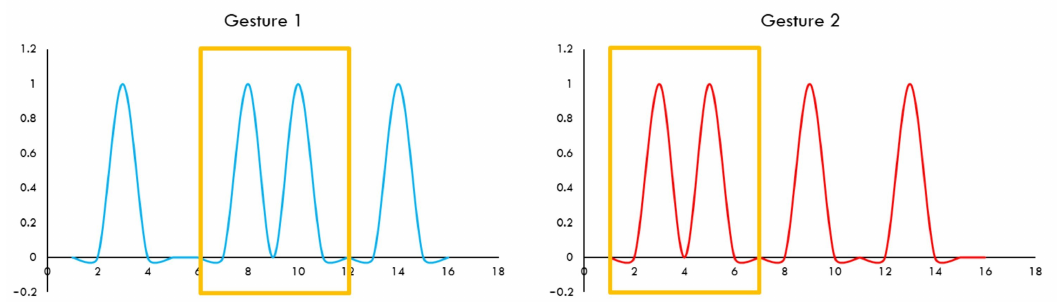
Figure 5. Two different gestures but with similar section, which can cause mismatching.